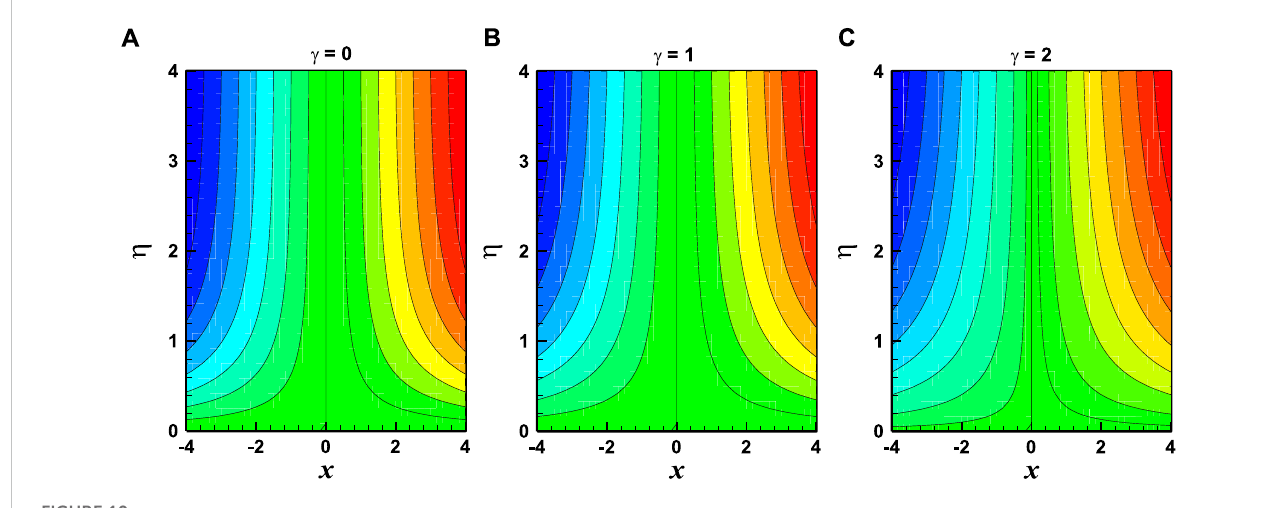
FIGURE 10 Variation of streamlines for Nb (cid:1) 0 . 3 , Nt (cid:1) 0 . 5 , Le (cid:1) 1 , Pr (cid:1) 3 . 97 , β (cid:1) 0 . 3 , Nc (cid:1) 0 . 5 , Gr (cid:1) 0 . 5 , M (cid:1) 0 .